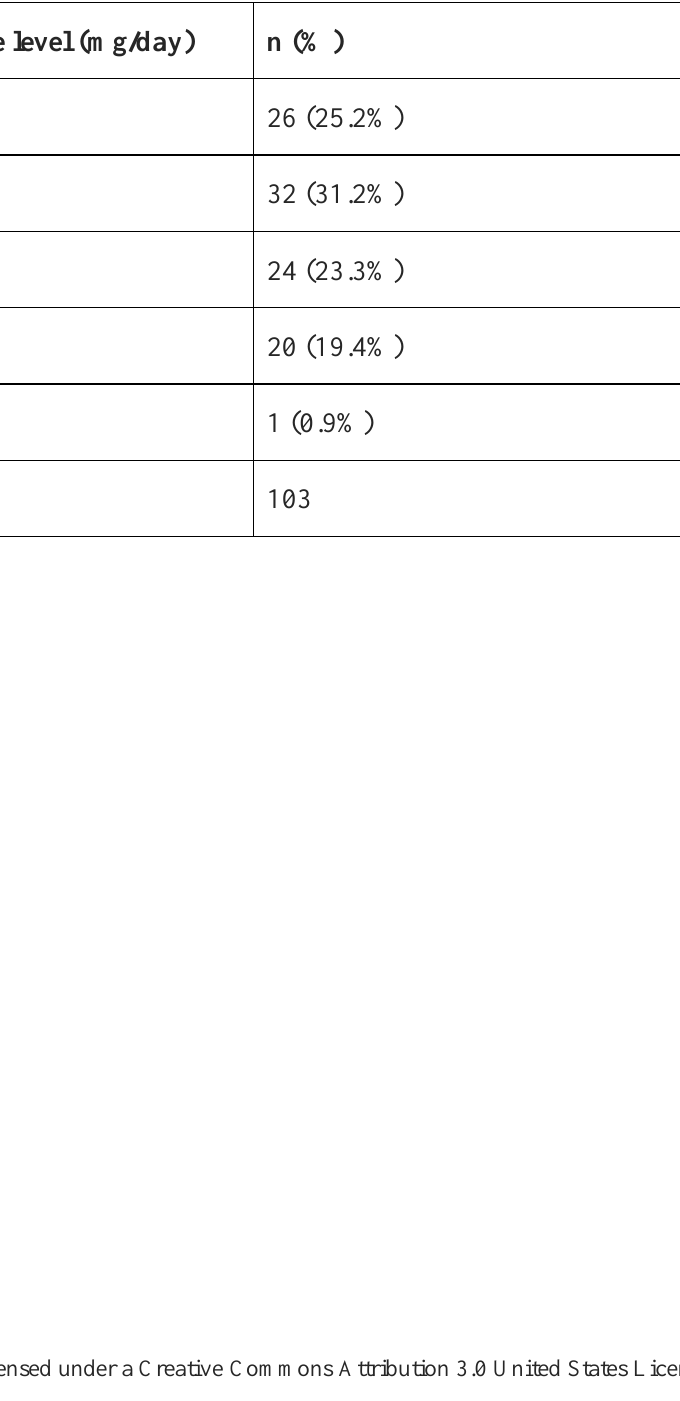
Table 2: Distribution of pregnant women by daily intake of choline